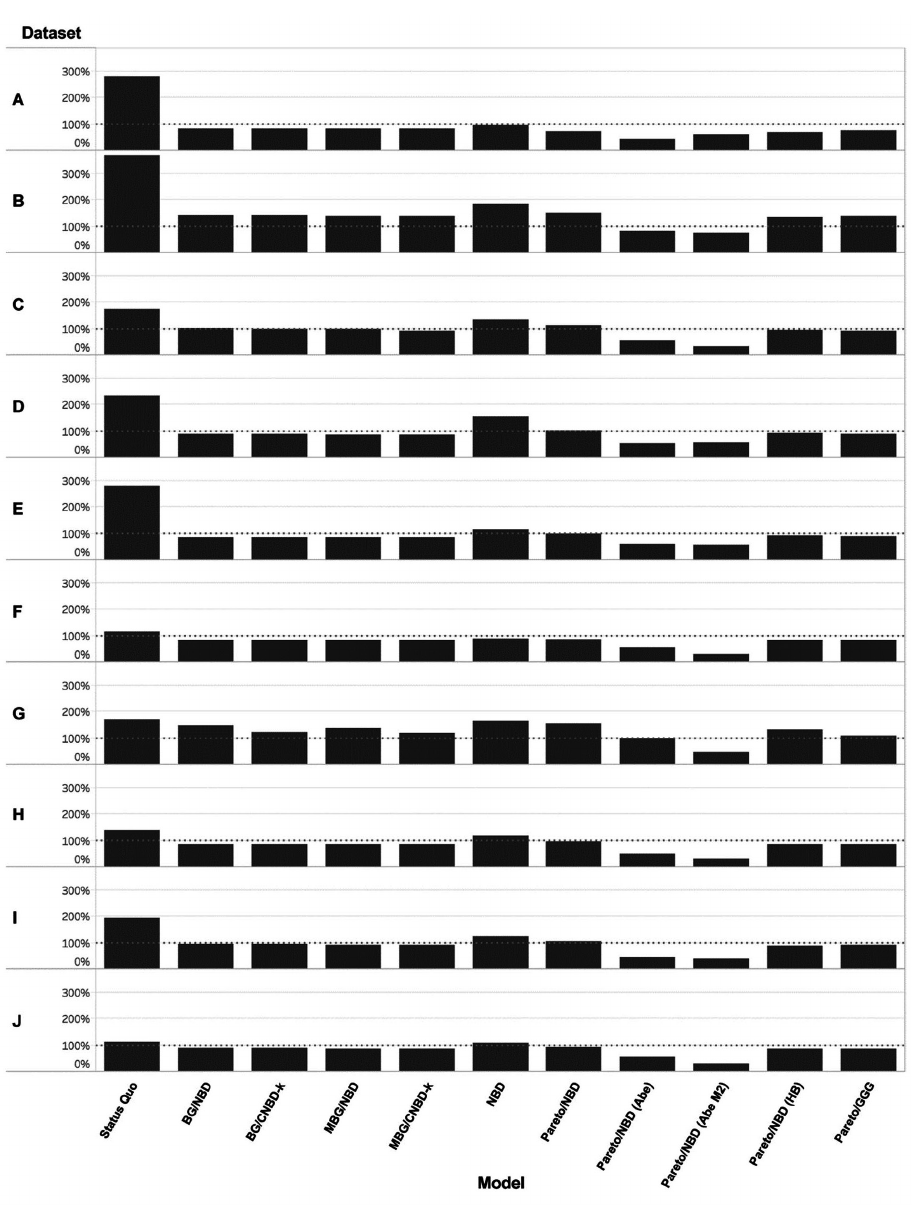
Figure 2. Results for Forecast vs. Actual (in %) for online stores